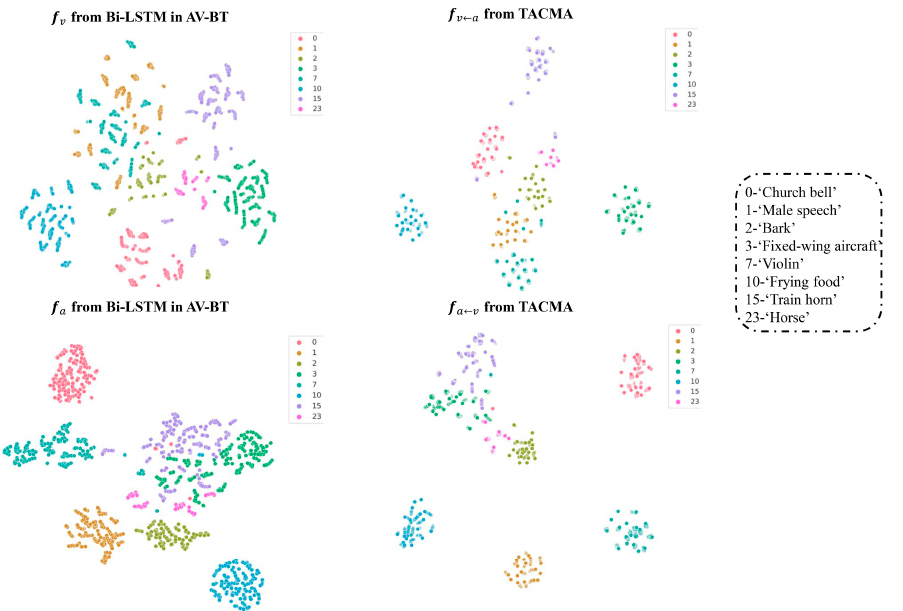
Figure 6. Illustration of the effect of the hyperparameter (cid:2016) in TACMA. The best result is in bold.